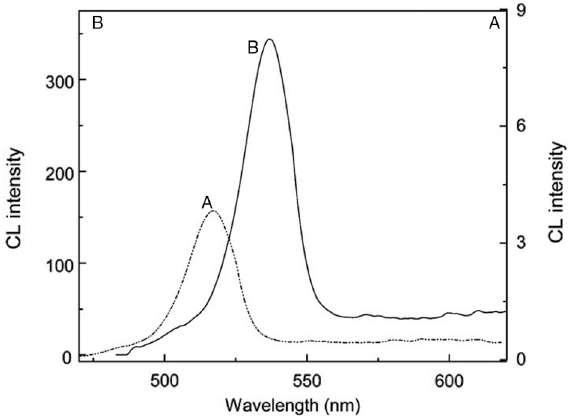
Figure 3: CL spectra of diperiodatoargentate(III)-isoxicam-fluorescein in the absence (A) and presence of CTAB (B). Reprinted with permission from Zhao and Si